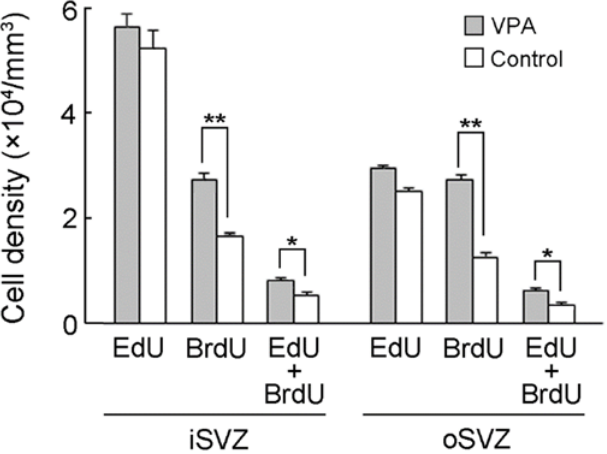
Figure 5. Densities of EdU single-, BrdU single-, and EdU/BrdU double-labeled cells in the iSVZ and oSVZ of the premature cortex of postnatal day (PD) 7 ferrets. Data are shown as mean ± standard error of the mean (SEM). Significance is indicated using Scheffe’s test at * p < 0.01, ** p < 0.001; number of ferrets = 3 each.